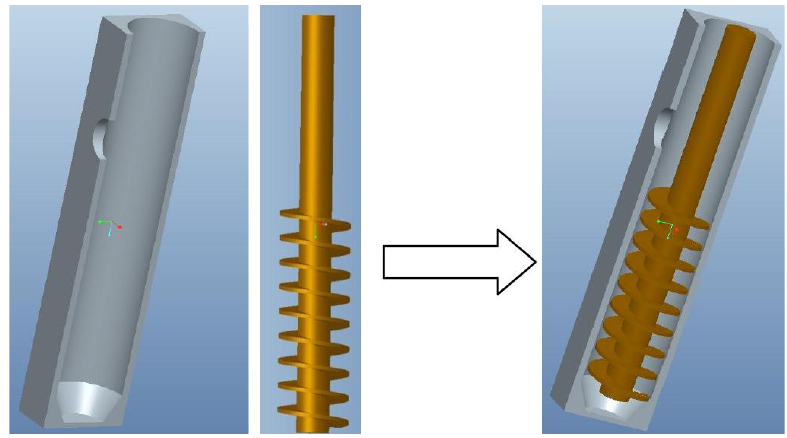
Figure 16. Simplified 3D model of FCM device.